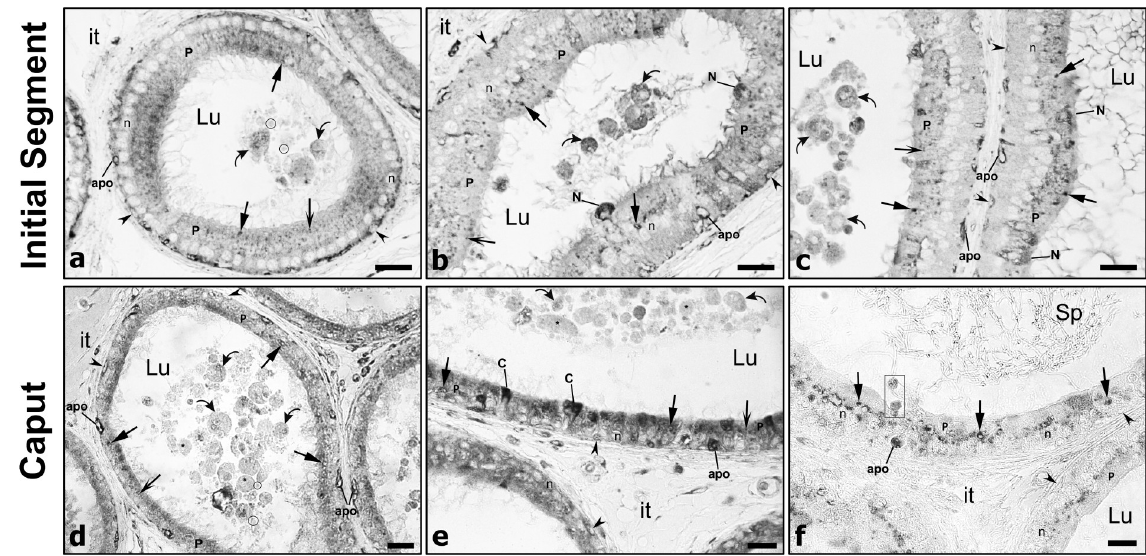
Fig 8. Apoptotic cells in the lumen of castrated animals with and without testosterone replacement. Lumen and epithelium of the initial segment (a-c) and caput epididymidis (d-f) immunostained with PSAP of castrated with testosterone supplementation (a-c) and castrated (Ct) animals (d), and with CatD of Ct animals (e, f). In the lumen a plethora of abnormal structures with diverse shapes, sizes and content are noted, with some revealing a nucleus (curved arrows). Other small and larger structures had a more homogeneous appearance but without much content (asterisks). Many tiny fragments with a homogeneous appearance were also evident in the lumen (circled). Sperm were not evident in the initial segment, but some were seen in the caput region (Sp). In Fig 7F an apopotic cell appears at the base of the epithelium, while other cells appear to be sloughing from the epithelium into the lumen (rectangular box). Overall, the presence of these abnormal structures/cells suggests the apoptotic state of some of the epithelial cells after castration. Lu, lumen; it, interstitial space; reactive basal (arrowheads), narrow (N) and clear (C) cells; n, nuclei of principal cells. Scale bars = 20 μ